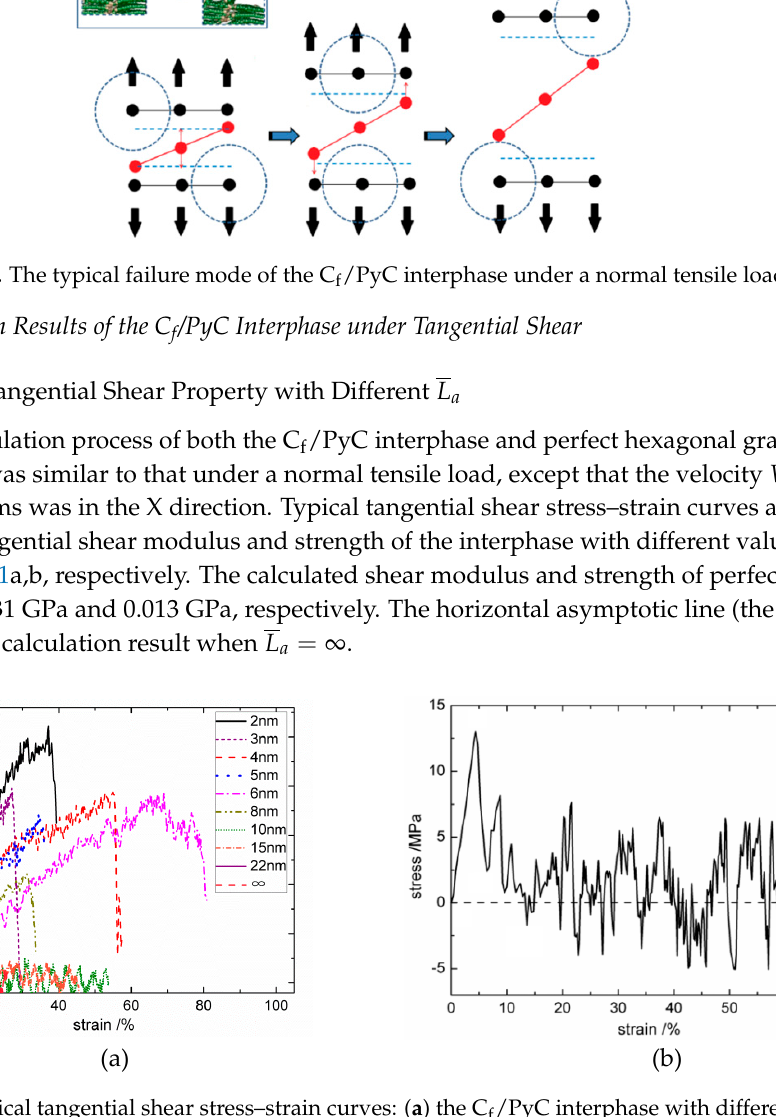
Figure 8. Typical failure modes of the C f /PyC interphase under a normal tensile load when